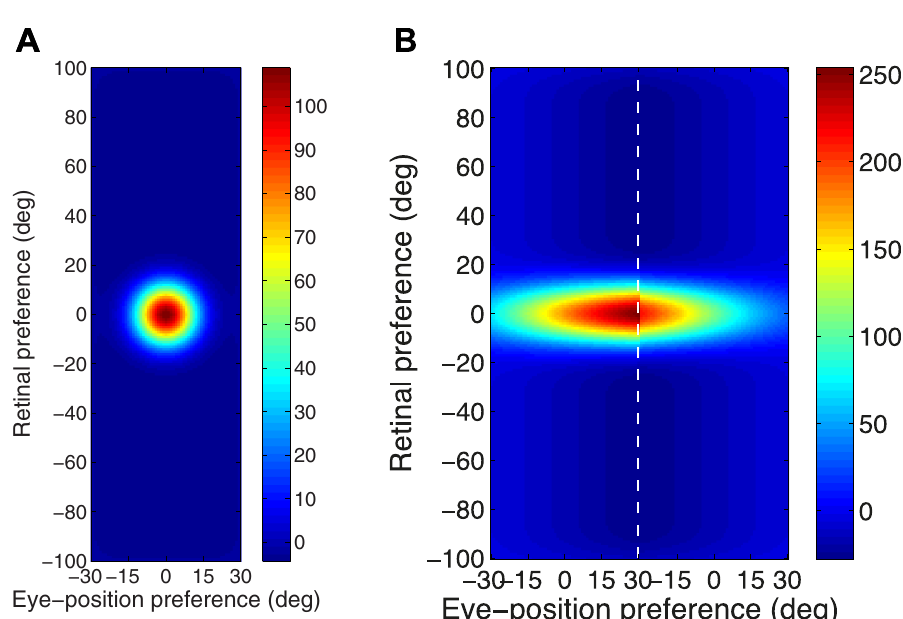
Fig 6. Covariance between a given input neuron and the rest of the input neuron population. Each plot shows the covariance between a given input neuron and the rest of the input neuron population in the form of a topographic map analogous to the weight vector maps shown above. Subplots (A) and (B) show results for input neurons with peaked and monotonic gain, respectively. In both cases the input neuron has preferences α = β = 0˚, and in the monotonic case the input has positive gain ( κ >